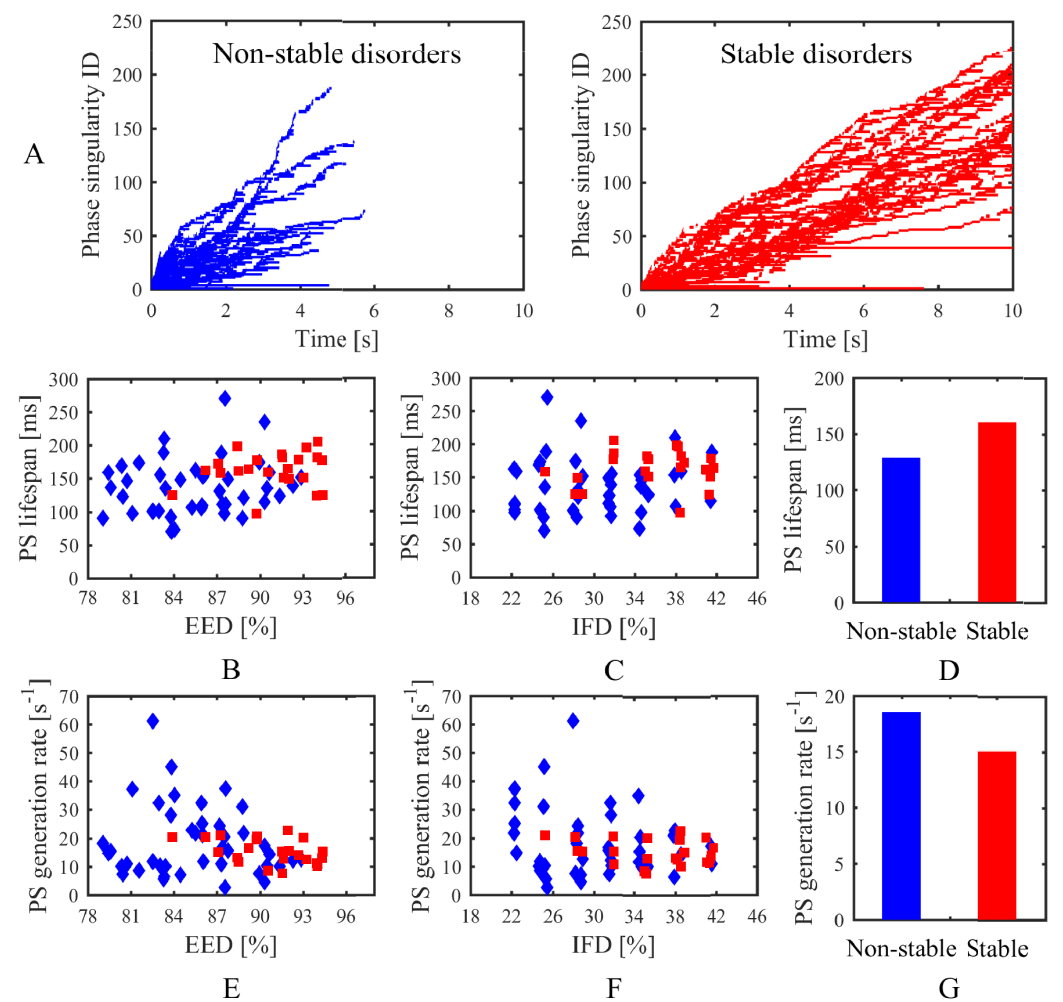
Fig 10. Lifespan of phase singularities in the stochastic group. (A) PS lifespans during the whole time in non-stable and stable disorders. Average lifespan of phase singularities for each simulation related to (B) endo-epicardial dissociation and (C) intramural fibrosis. (D) Average lifespan of phase singularities for all simulations in non-stable and stable disorders. Average generation rate of phase singularities for each simulation related to (E) endo-epicardial dissociation and (F) intramural fibrosis. (G) Average generation rate of phase singularities for all simulations in non-stable and stable disorders. Red squares denote stable disorders. Blue diamonds denote non-stable disorders. IFD is the intramural fibrosis degree and EDD is the endo-epicardial dissociation